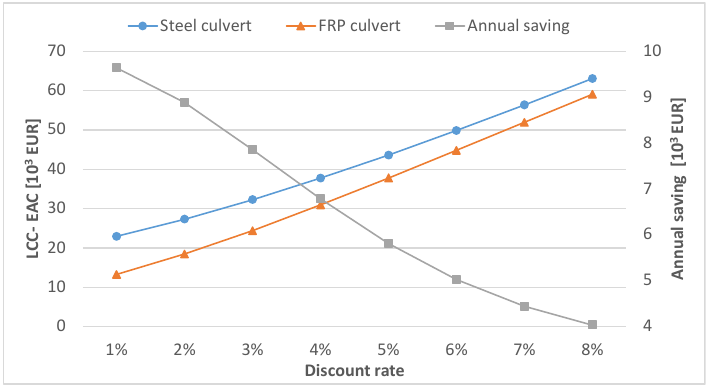
Figure 13. Impact of discount rate on the total LCC and saving ratio.